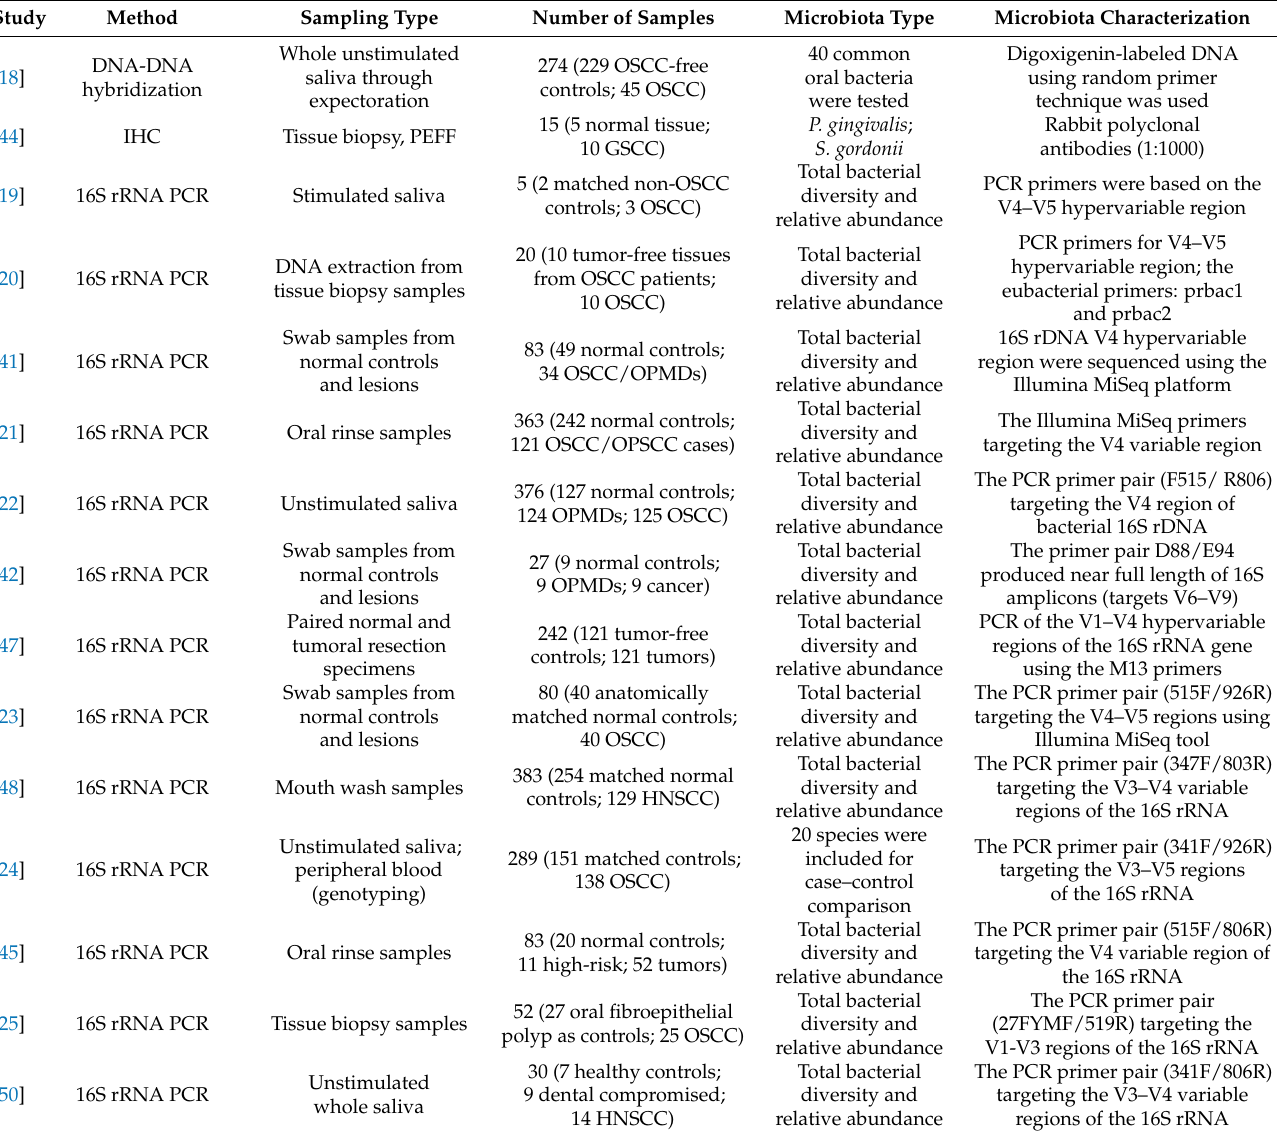
Table 2. The various methods applied in the included